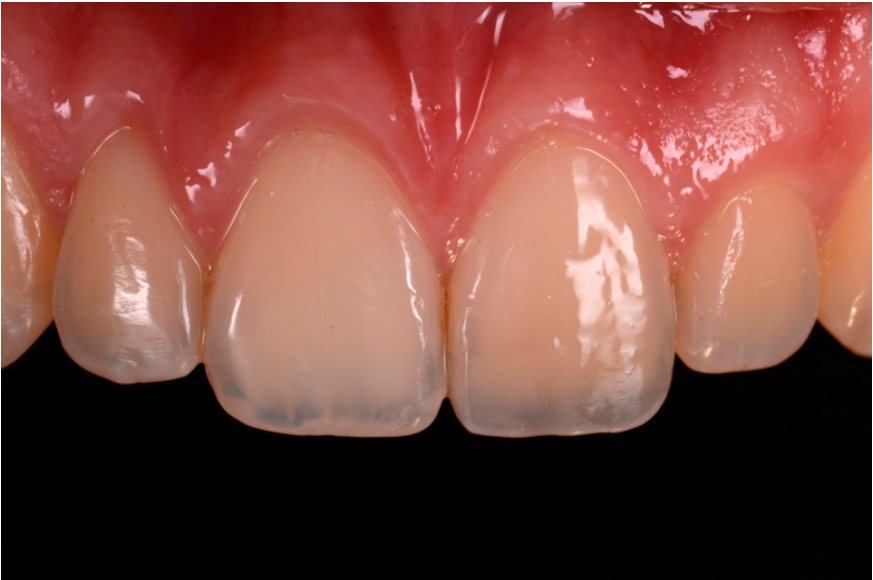
Figure 58. A more accurate management of the frame could have improved the thin and not festooned incisal opaque margin on left central incisor.